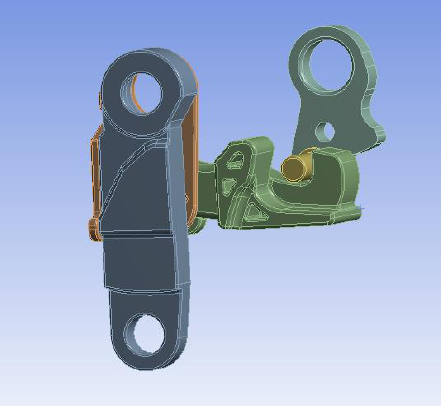
Figure 11. Simplified door latch simulation model.